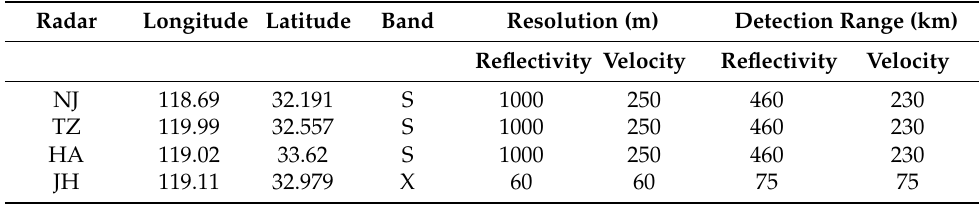
Table 1. Information of the weather radars.